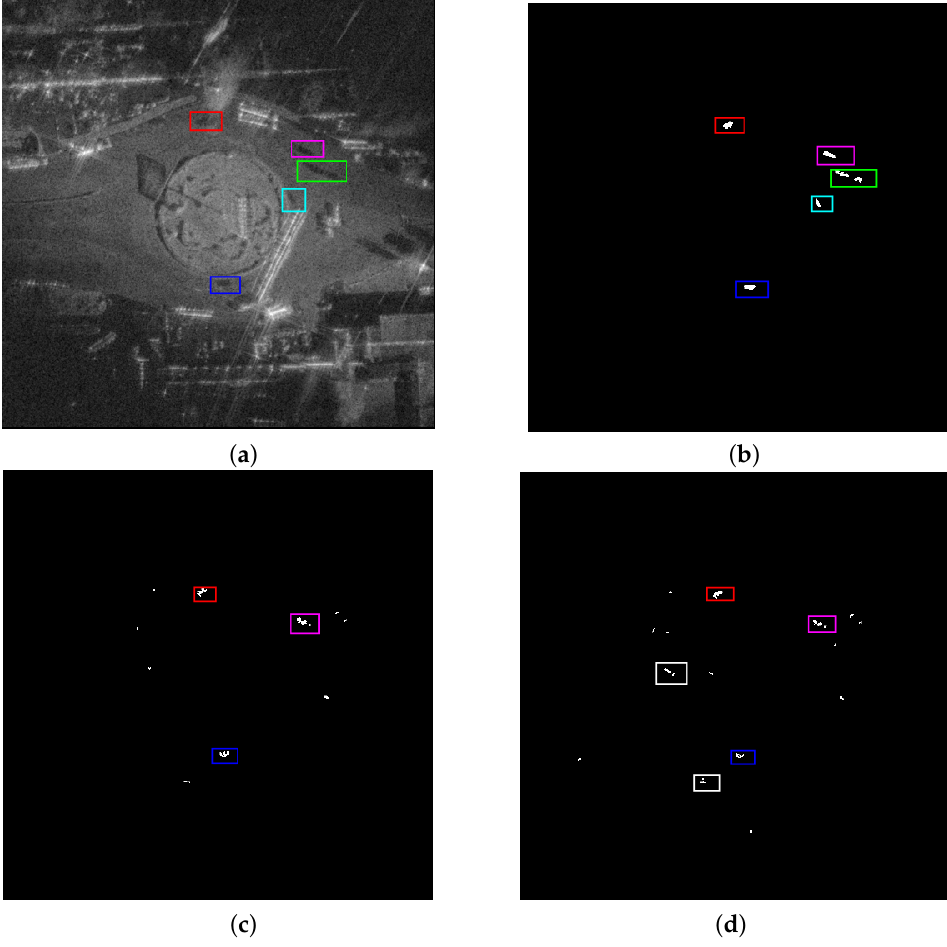
Figure 8. Detection results of the 18th image using different methods. ( a ) Initial image. ( b – d ) LRSD- BIIANS method, LRSD-CFAR method, and MEAN-CFAR method, respectively. The five colored rectangles represent five ground moving targets. The white rectangles are the false